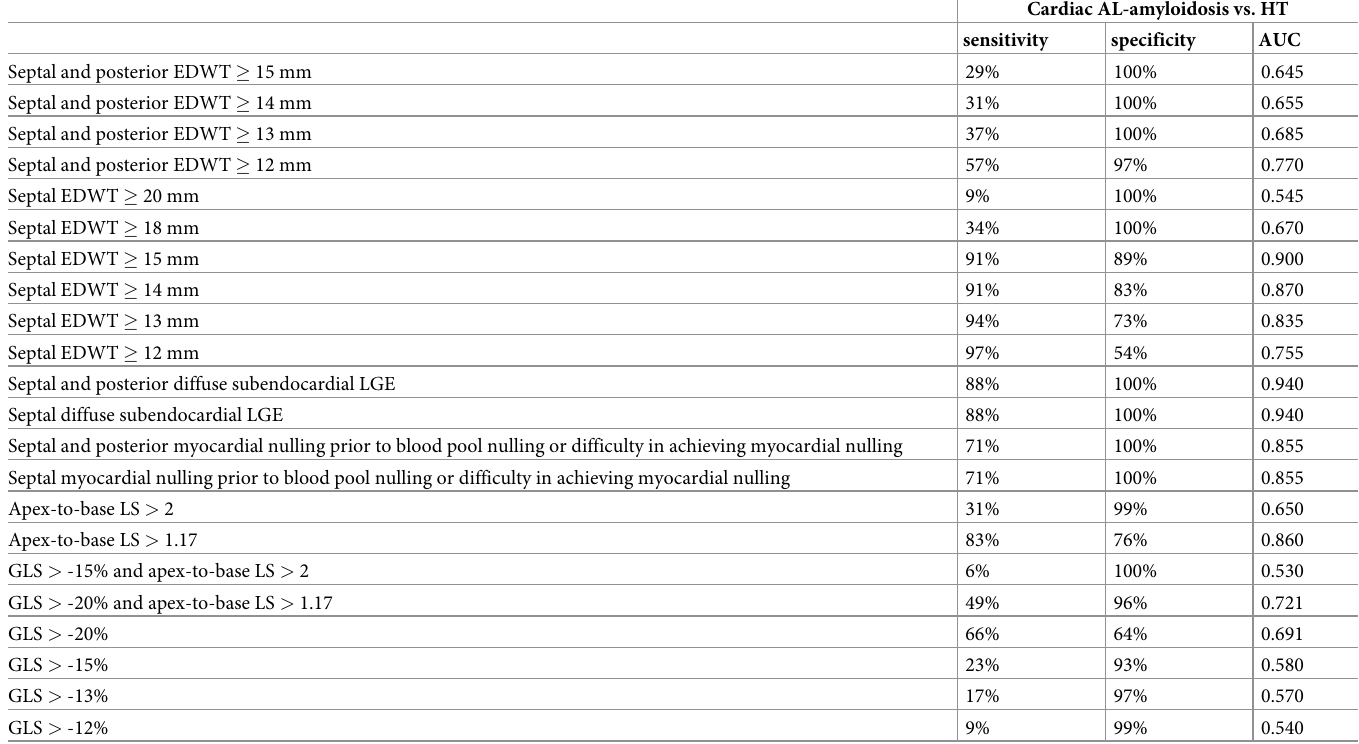
Cardiac AL-amyloidosis vs.